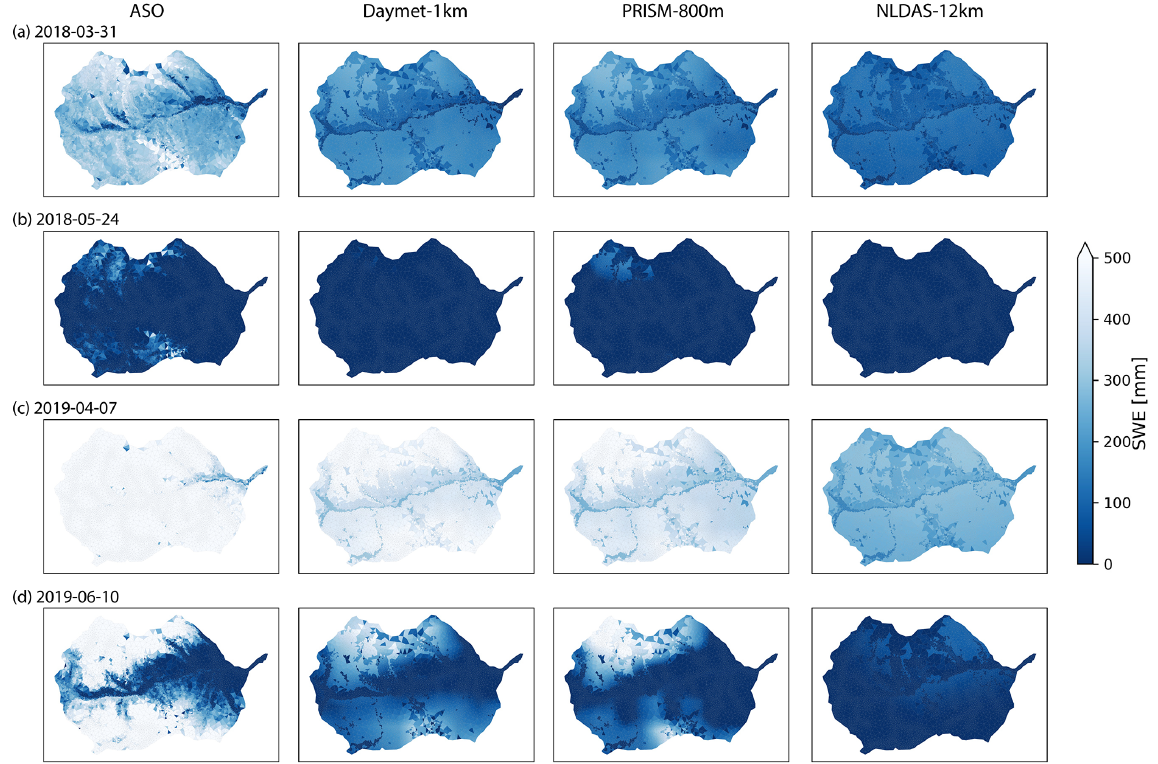
Figure 9. Spatial distribution of SWE under different meteorological forcings and their comparison with ASO SWE data at four different survey times.